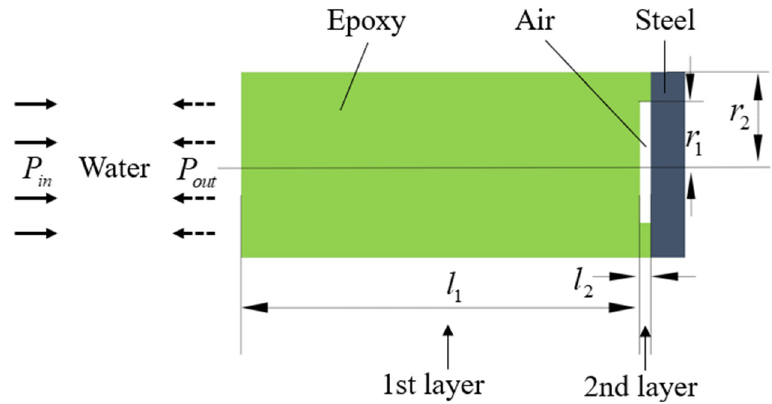
Figure 2. Structural parameters and working conditions of typical cell of SSC.